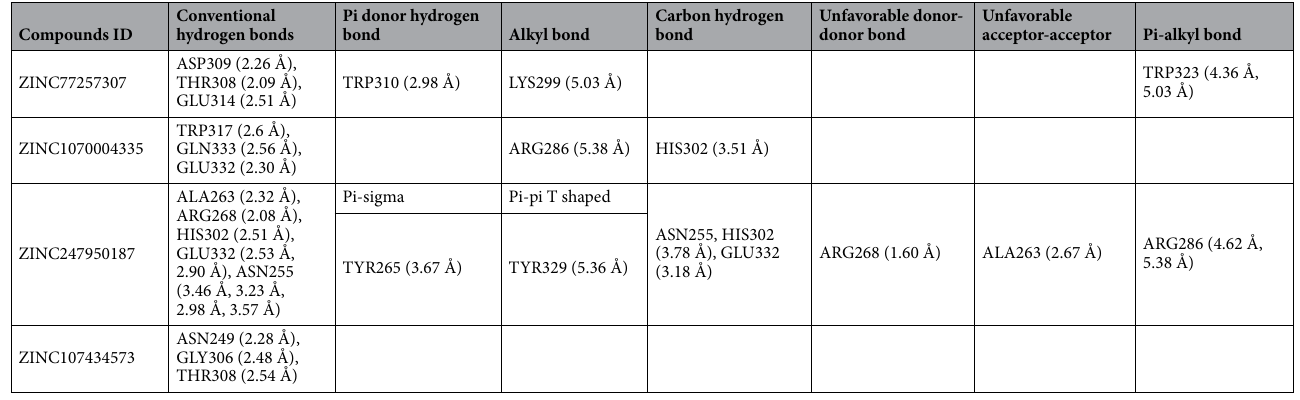
Table 3. Interaction result between the selected 4 ligands in complex with the protein